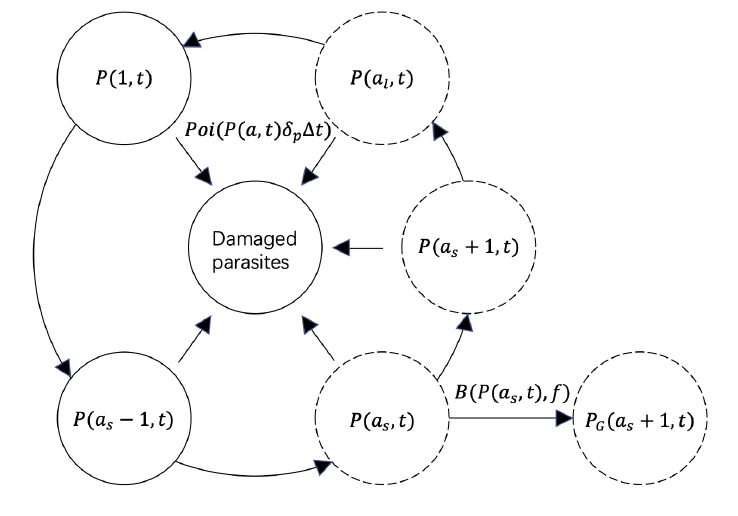
Figure 1. Schematic diagram showing the model compartments and transitions. P ( a , t ) represents the number of asexual parasites with age a at time t , where a denotes the developmental stage of parasites, a ∈ [ 0, a L ] and t denotes the time of interest, t ∈ [ 0, + ∞ ) . The history and contribution of mathematical models for the population biology of malaria infection and treatment has been reviewed in [4], which provides an overview of the developmental process and need for models that account for the age a of parasites. The loop of P ( a , t ) represents the a L -hour life cycle of asexual parasites. During the life cycle, parasites may die and become damaged parasites, which can be modelled deterministically as in Equation (1) or stochastically by a Poisson process with a rate P ( a , t ) δ p ∆ t where δ p is the natural death rate of parasites. Sexual commitment occurs at age a s where a small fraction f of the asexual parasites enter the sexual development to become sexually committed parasites P G ( a s + 1, t ) . The compartments with a dashed boundary represent the stages of parasites that are sequestered to tissues and thus not measurable by blood